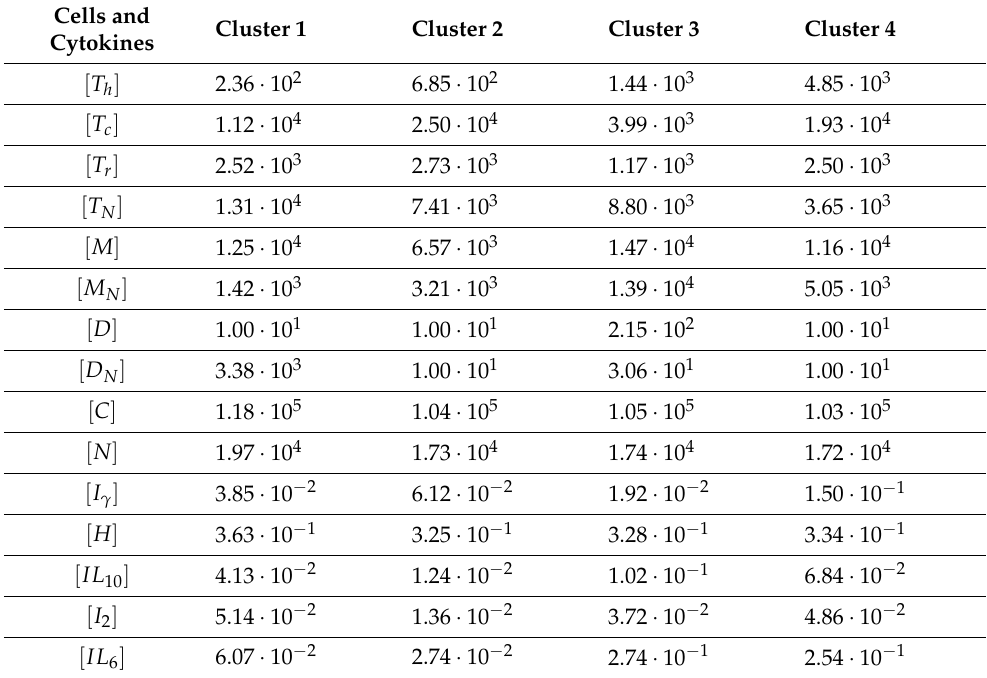
Table 3. Steady state values of the cells and cytokines. Cells